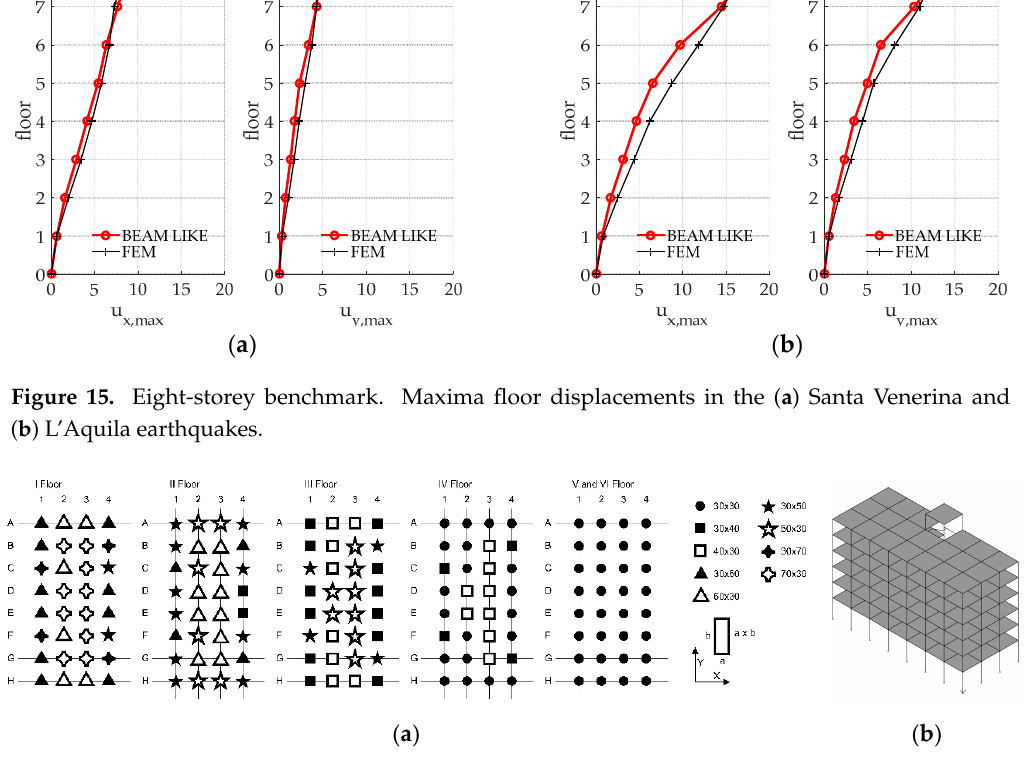
Figure 16. Six storey building benchmark (Model 2): ( a ) the column cross section plan and ( b ) the FEM model.